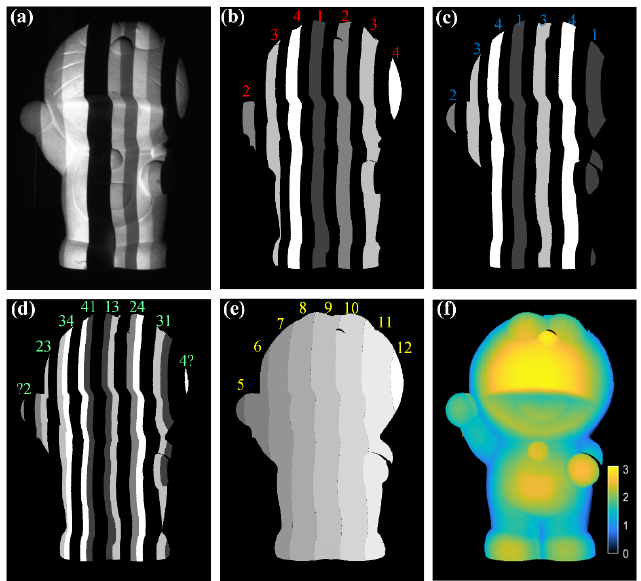
Figure 7. Processing of the sculpture of Doraemon. ( a ) Captured coded pattern. ( b ) The map of C 1 . ( c ) The map of C 2 . ( d ) The map of 2-bit codewords C 1 C 2 . ( e ) The map of fringe orders. ( f ) The result of 3D reconstruction.